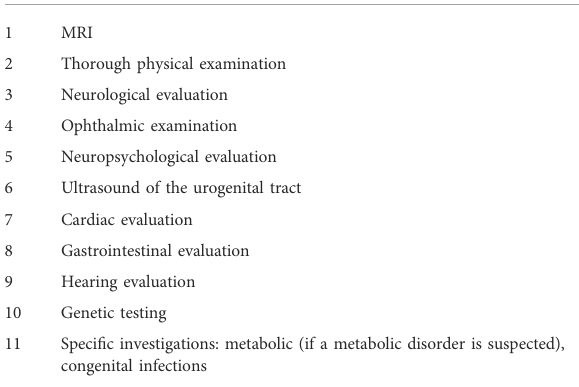
TABLE 3 Suggested diagnostic evaluations in a postnatal patient with